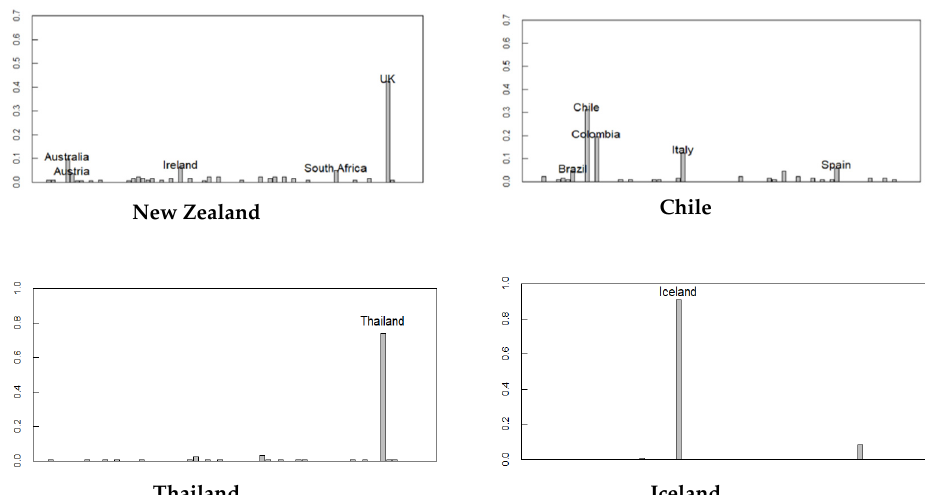
Figure 2. Distribution of ethnicity in each country; (x-axis) countries; (y-axis) probability